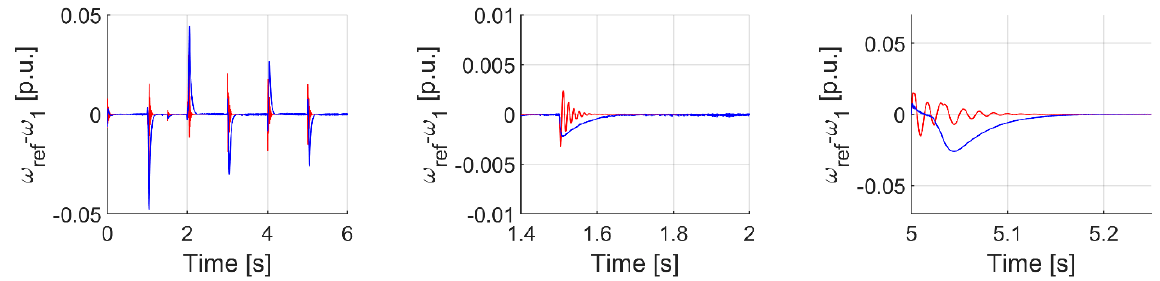
Figure 27. Transients of difference between motor and load speed for analyzed controller cases.